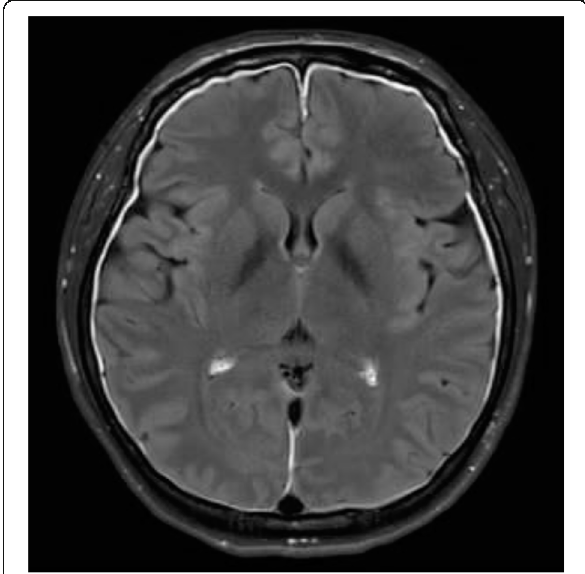
Fig. 1 (abstract P34). Brain MRI show diffuse pachymeningeal thickening and enhancement